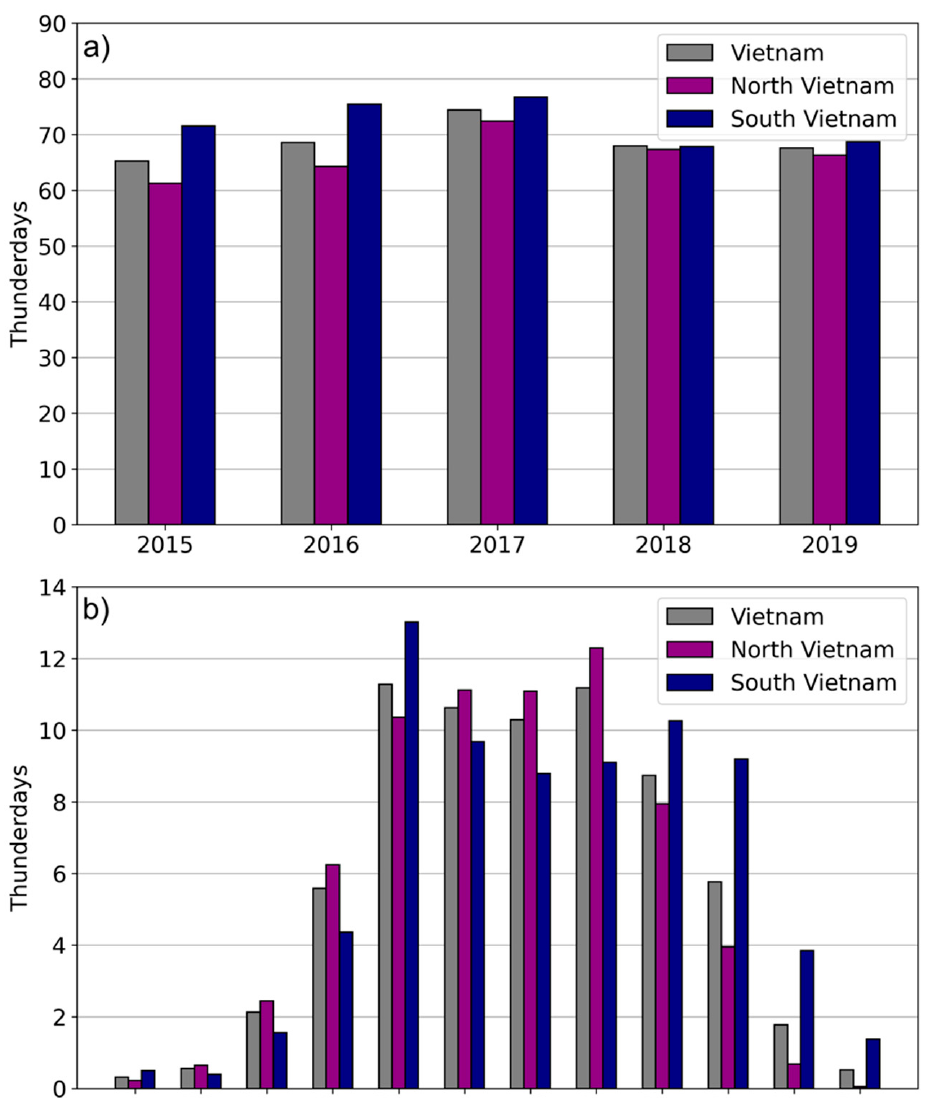
Figure 6. The annual ( a ) and monthly ( b ) mean number of thunderstorm days in North, South and the whole of Vietnam from 2015 to 2019 according to manual observations plotted in Figure 1.